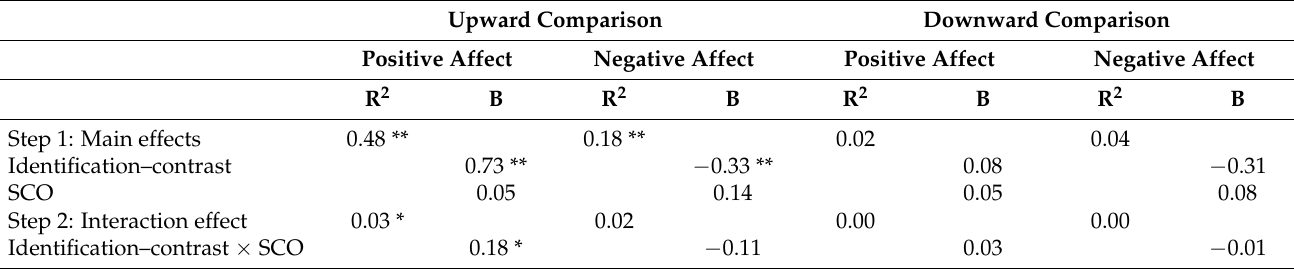
Table 4. Results of hierarchical regression of positive and negative affect after upward and downward comparison on identification–contrast and SCO [13].